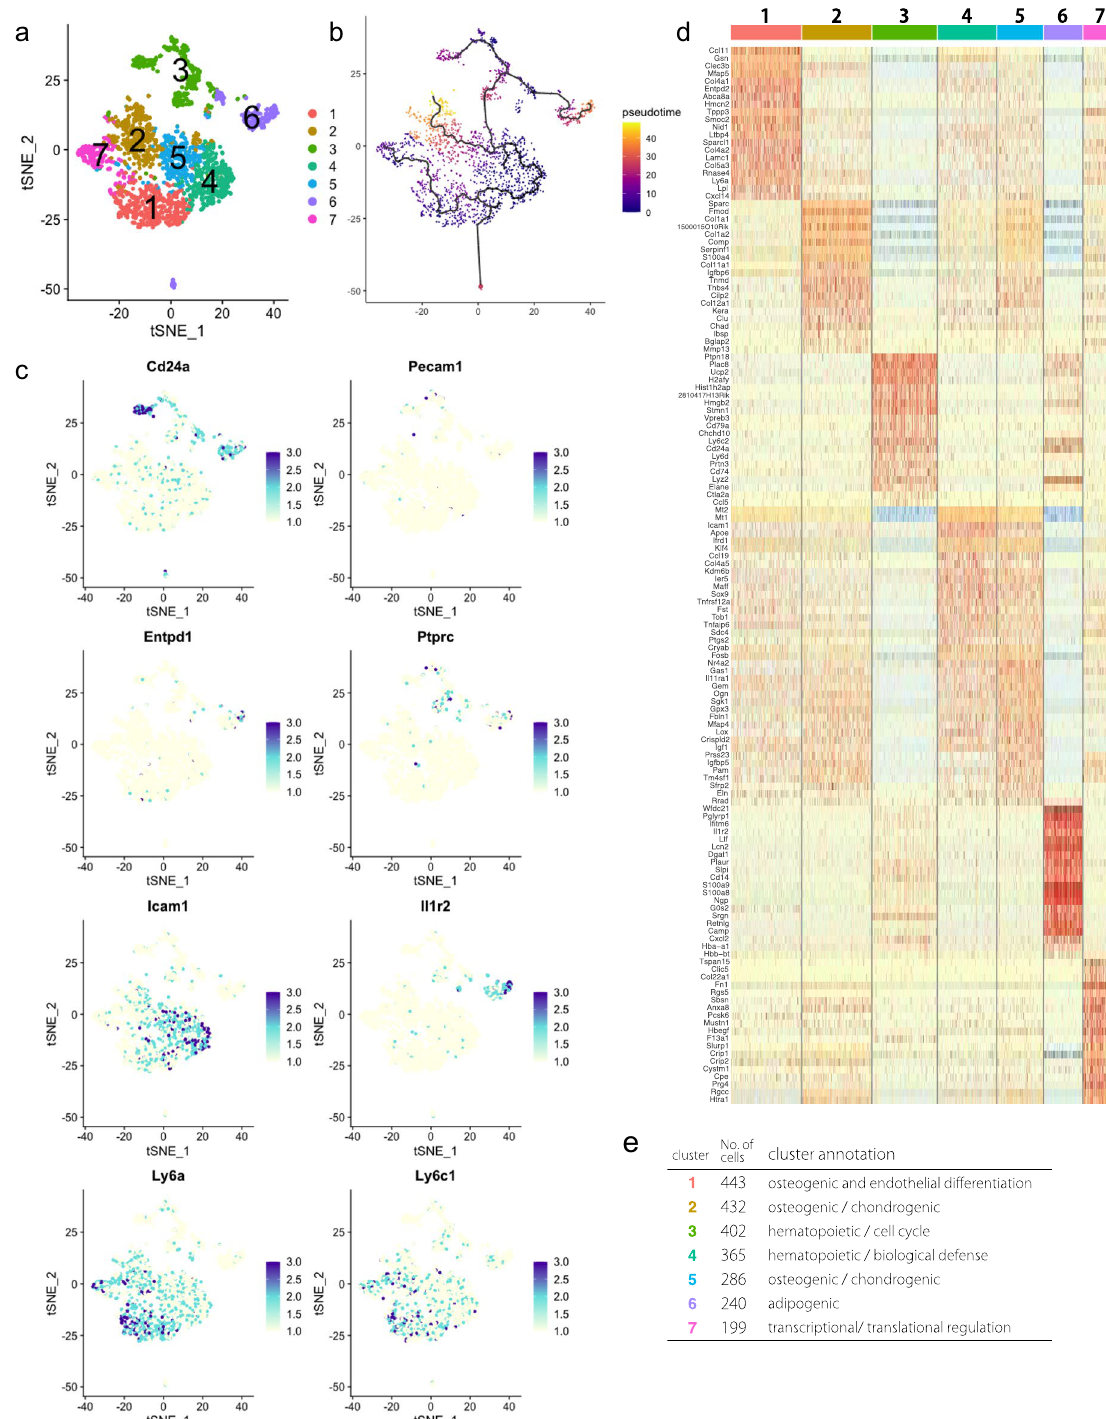
Figure 1. Single cell RNA-seq (scRNA-seq) analysis for the Pα-S fraction cells (n = 2367). ( a ) Dimension reduction map with tSNE by Cell Ranger. ( b ) Pseudotime analysis by Monocle3 on seurat object, setting origin to cluster 4. ( c ) Feature plot for marker genes, Cd24a, Cd31 (Pecam-1), Cd39 (Entpd1), Cd45 (Ptprc), Cd54 (Icam1), Cd121b (Il1r2), Sca-1 (Ly6a), Ly6c1. ( d ) Heatmap of top 10 upregulated genes in each cluster (color code as in Fig. 1a). ( e ) Table of each cluster annotation in functional